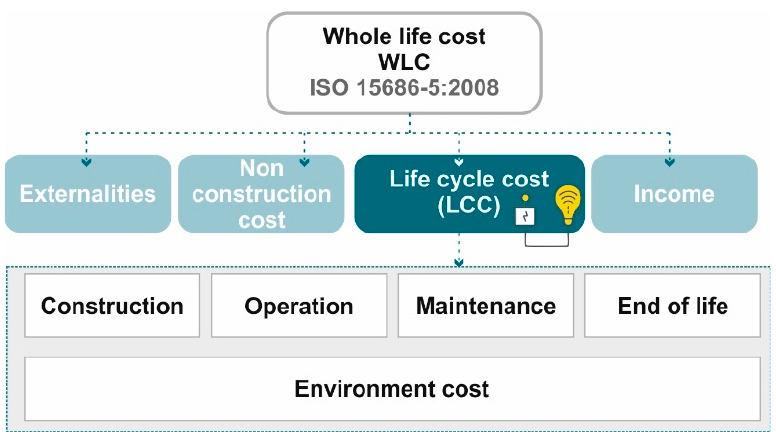
Figure 4. ISO 15686-5, life cycle cost.